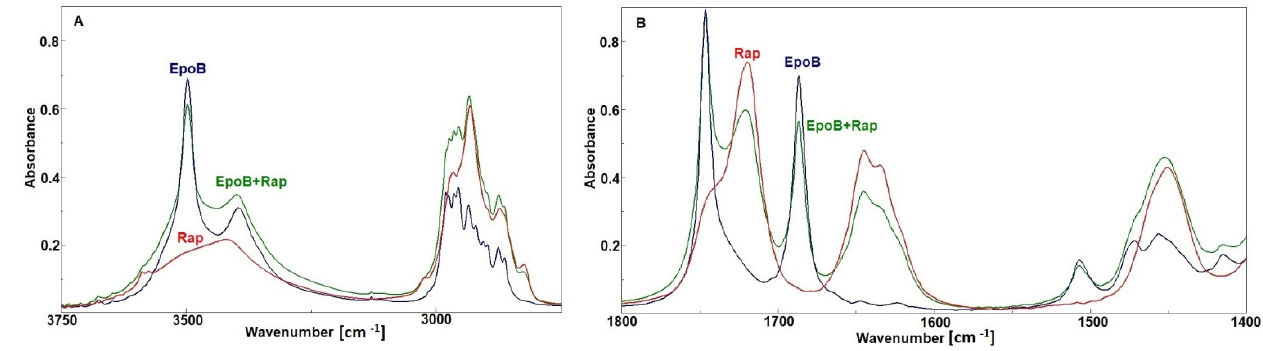
Figure 6. The FTIR spectra of rapamycin (Rap), epothilone B (EpoB), and a mixture of them ( A , B ). Table 5. Live cell proteins level expressed as a percent of controls (mean values ± standard deviations) in MDA-MB-231 cells after 72 h exposure with free EpoB and Rap, and the drugs-loaded micelles and microspheres measured with sulforhodamine B assay (TOX-6). Statistically significant differences vs. controls were denoted by asterisks ( p < 0.05). Drugs Concentration Free